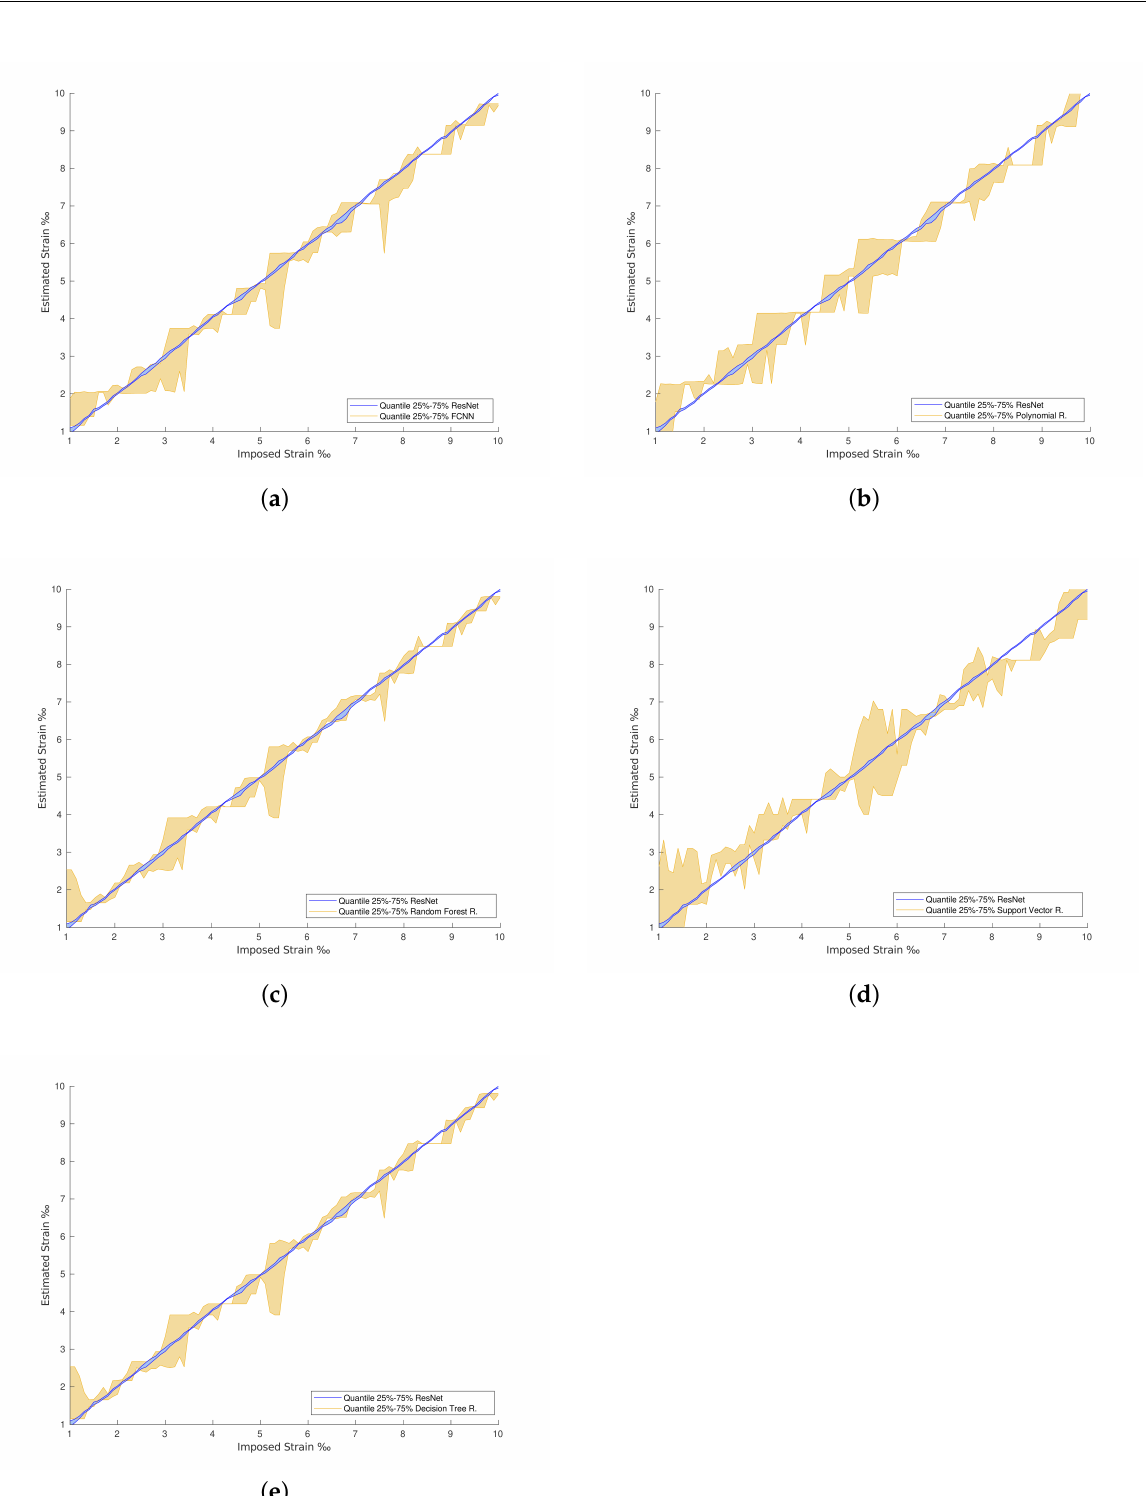
Figure 13. ResNet with regression vs. machine learning predictions. ( a ) ResNet with regression vs. FCNN with regression predictions. ( b ) ResNet with regression vs. Polynomial Regression predictions. ( c ) ResNet with regression vs. Random Forest Regression predictions. ( d ) ResNet with regression vs. Support Vector Regression predictions. ( e ) ResNet with regression vs. Decision Tree Regression